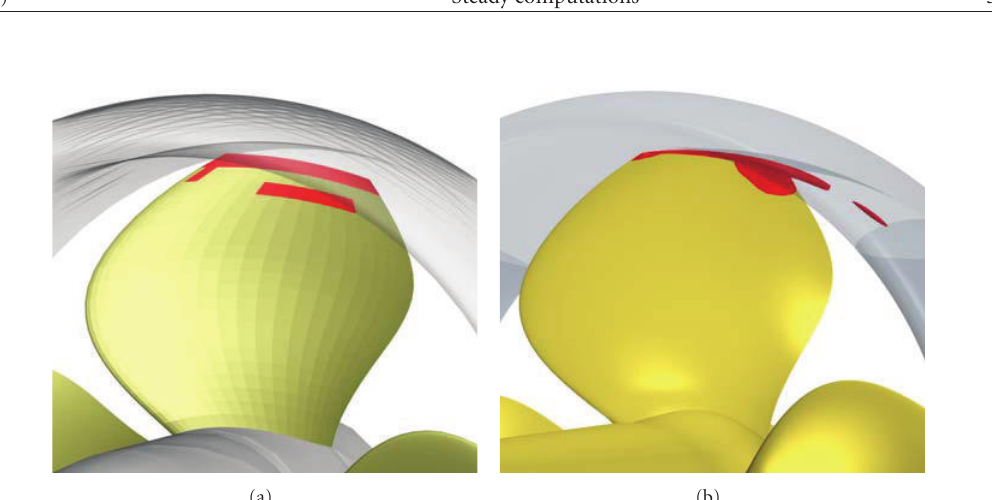
Figure 7: Predicted cavity extension for the preliminary propeller geometry at the design advance coe ffi cient. (a) Panel method computations at 90% of the design cavitation index. (b) RANS computations at the design cavitation